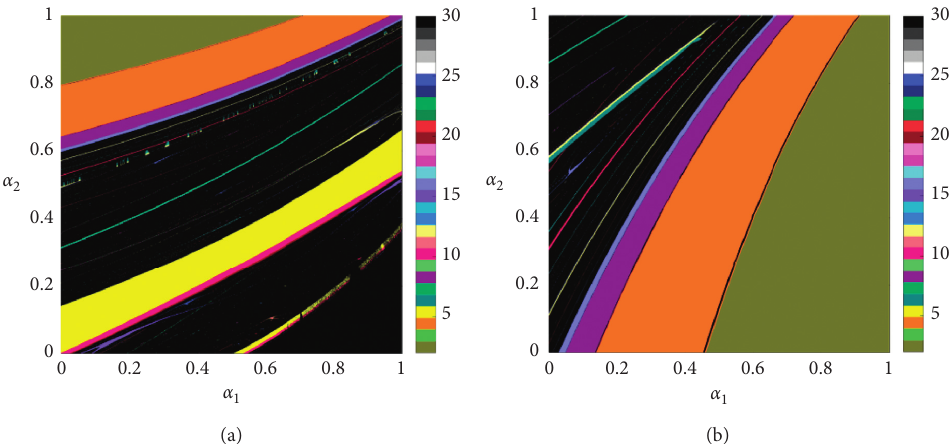
Figure 3: The 2-D bifurcation diagrams about α � 0 . 26457329, and v b � 0 . 92281351, v 1